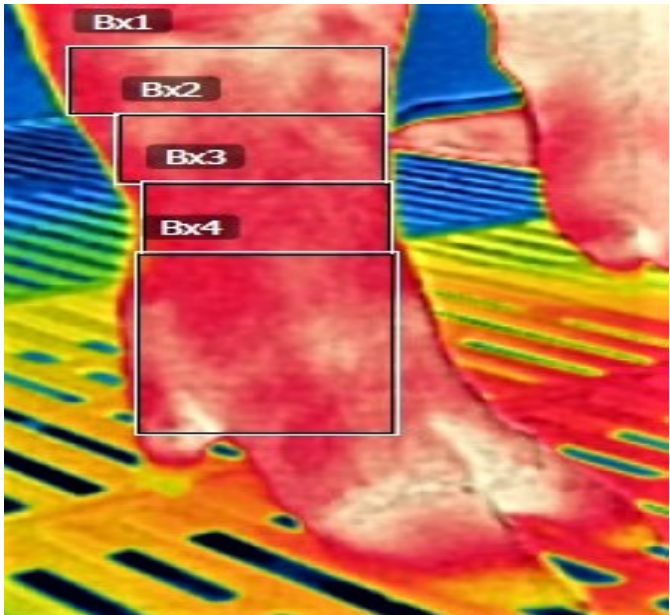
Figure 1. Areas of temperature measurement by IR camera in sows of different genetic lines in three farrow-to-finish herds in Greece: IRT1(Bx1) Carpus-Tarsus, IRT2(Bx2) Upper metacarpi/metatarsi, IRT3(Bx3) Lower metacarpi/metatarsi, IRT4(Bx4) Phalanges.